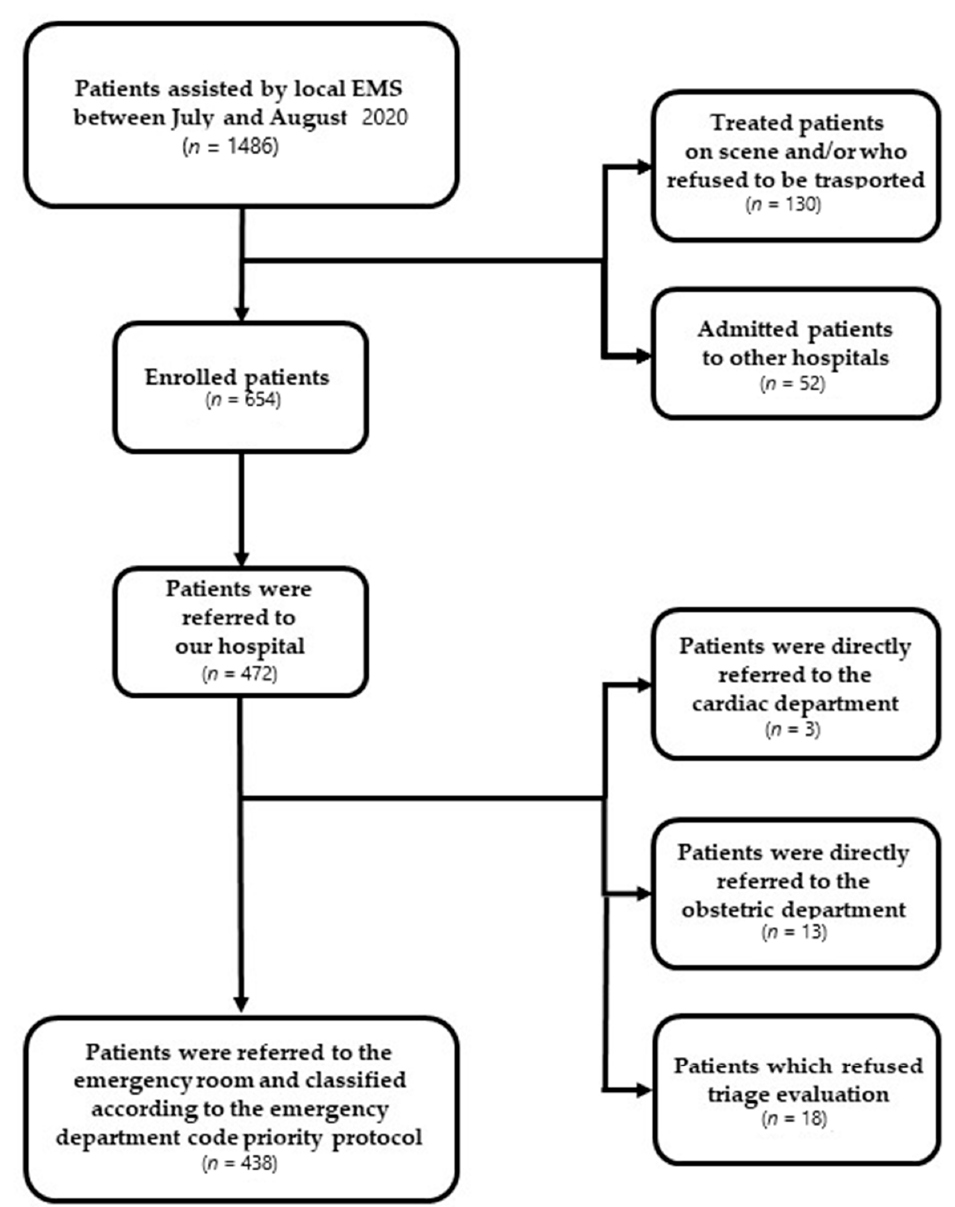
Figure 2. Results